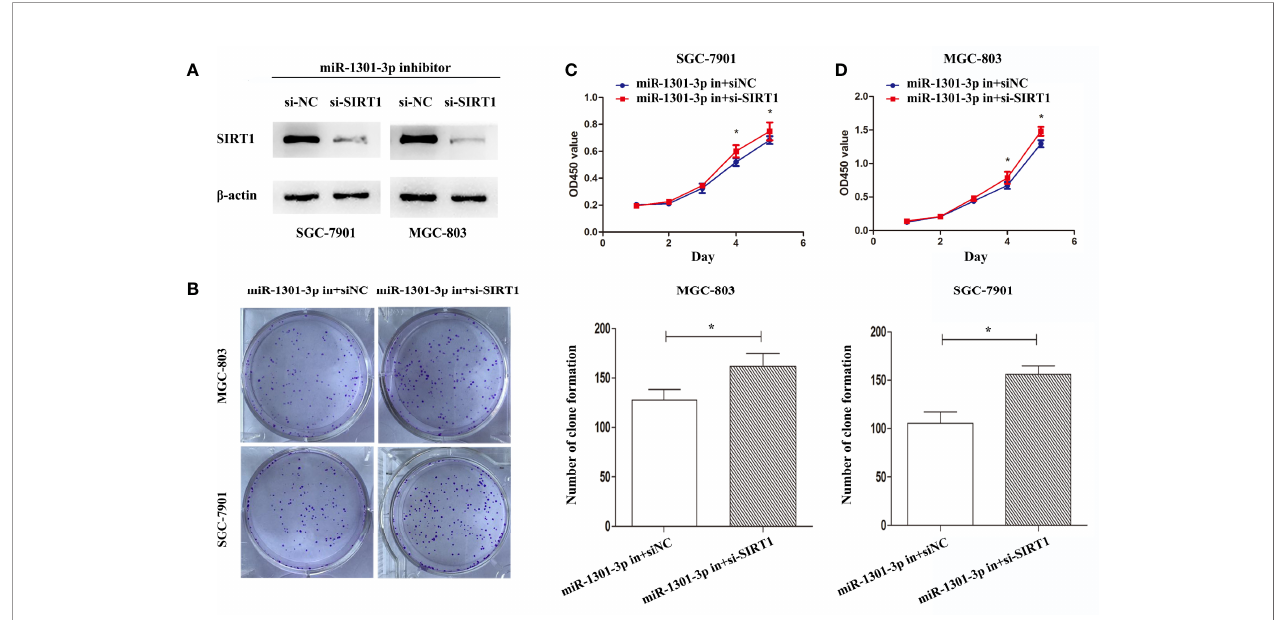
FIGURE 7 | Knockdown of SIRT1 in gastric cancer cells transfected with miR-1301-3p inhibitor enhanced the ability of proliferation. (A) Western blotting was utilized to verify the ef fi cacy of transfection. (B) Colony formation assay demonstrated that knockdown of SIRT1 and miR-1301-3p simultaneously promoted cell proliferation in gastric cancer. (C, D) CCK-8 assay demonstrated that knockdown of SIRT1 and miR-1301-3p simultaneously promoted cell proliferation in gastric cancer. *p <